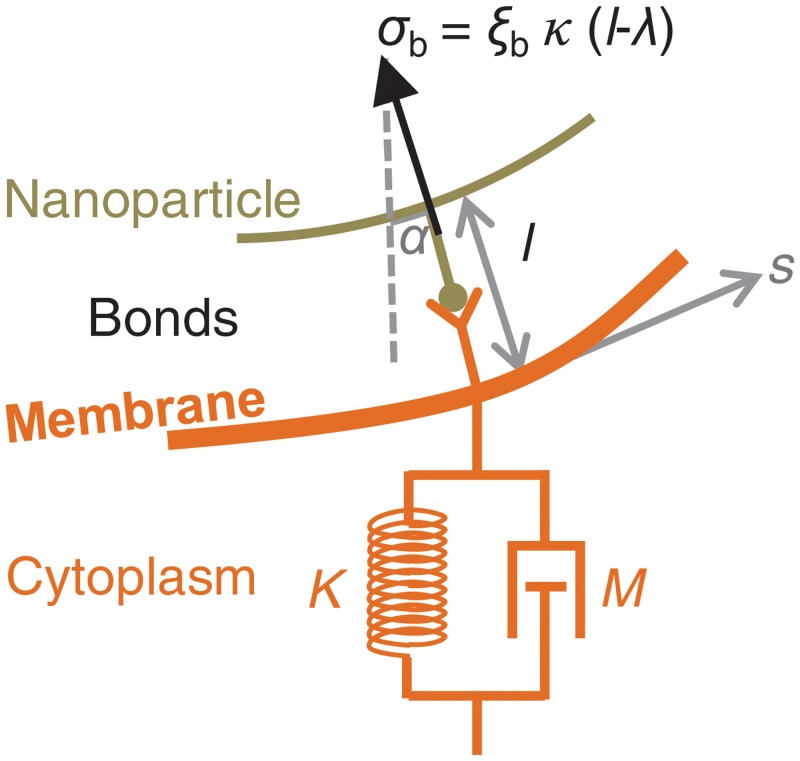
Schematic of the stresses exerted on the membrane.The membrane’s top face sustains a stress σ
b arising from bond deformation. The bonds behave as linear elastic springs of constant κ and undeformed length λ. In addition, if the membrane and the particle get very close, a short-range repulsion force (not represented in the figure) prevents particle-membrane interpenetration. The membrane’s bottom face sustains a stress arising from the viscoelastic deformation of the cell’s cytoplasm, which is modeled as a Kelvin-Voigt material of elastic constant K = E/a and viscous constant M = μ/a.